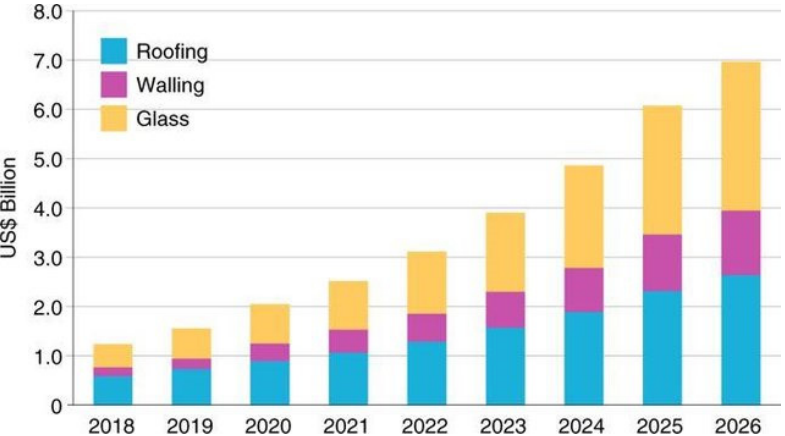
Figure 2. Predicted annual worldwide BIPV commercial market revenue (2018–2026) [14].